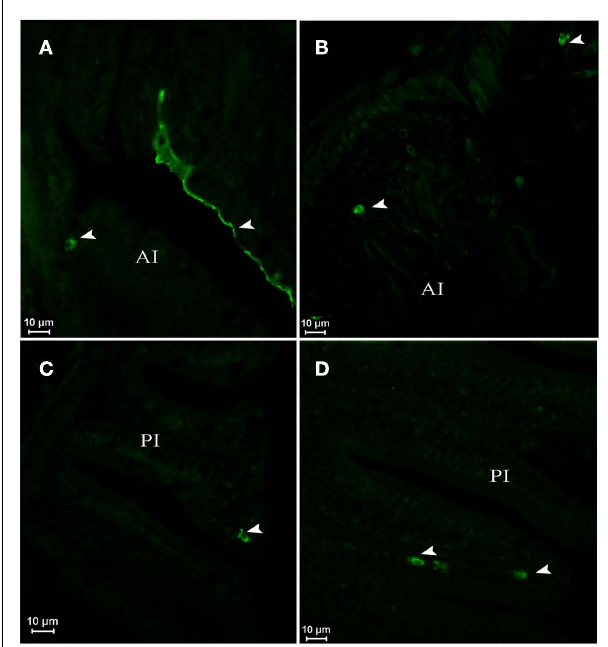
FIGURE 5 | Dicentrarchus labrax. AQP1a immunolocalization in anterior (A,B) and posterior intestine (C,D) of SW- (A,C) and DSW-acclimated (B,D) postflexion larvae at D42.The presence of AQP1a-cells and epithelial cell fluorescence is indicated by arrows. AI, anterior intestine; PI, posterior intestine; SW, sea water; DSW, diluted sea